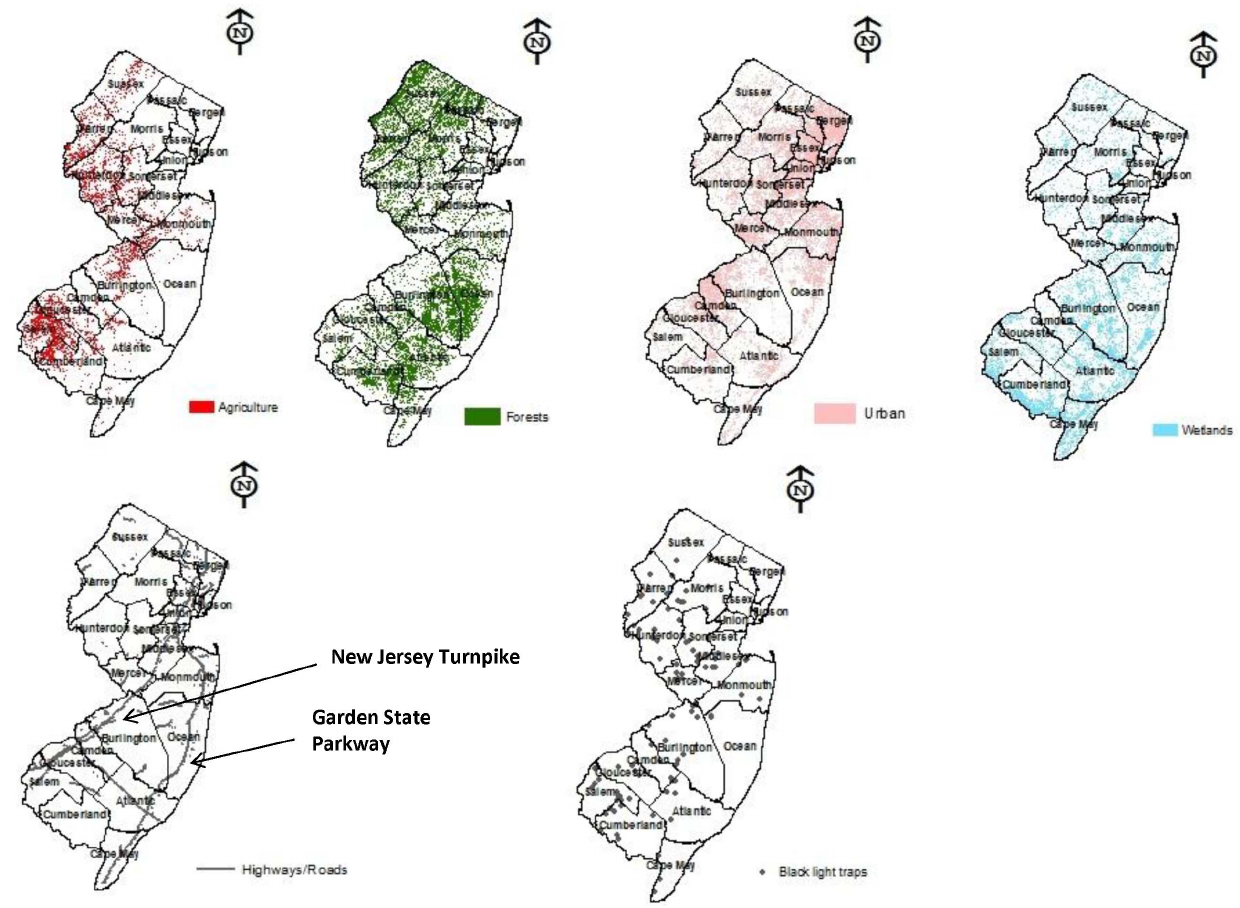
Figure 1. Maps of New Jersey displaying the five main landscape/land use features used in the analysis, including agriculture, forests, urban/residential, wetlands, and major highways and roads; the New Jersey Turnpike and The Garden State Parkway are shown in grey; and distribution of black light traps throughout New Jersey are also provided.